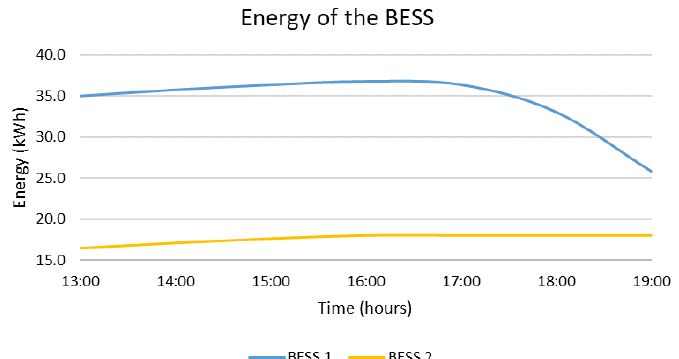
Figure 8. Energy stored in each BESS for islanded operation from 13:00 to 19:00. Figure 8 . Energy stored in each BESS for islanded operation from 13:00 to 19:00.